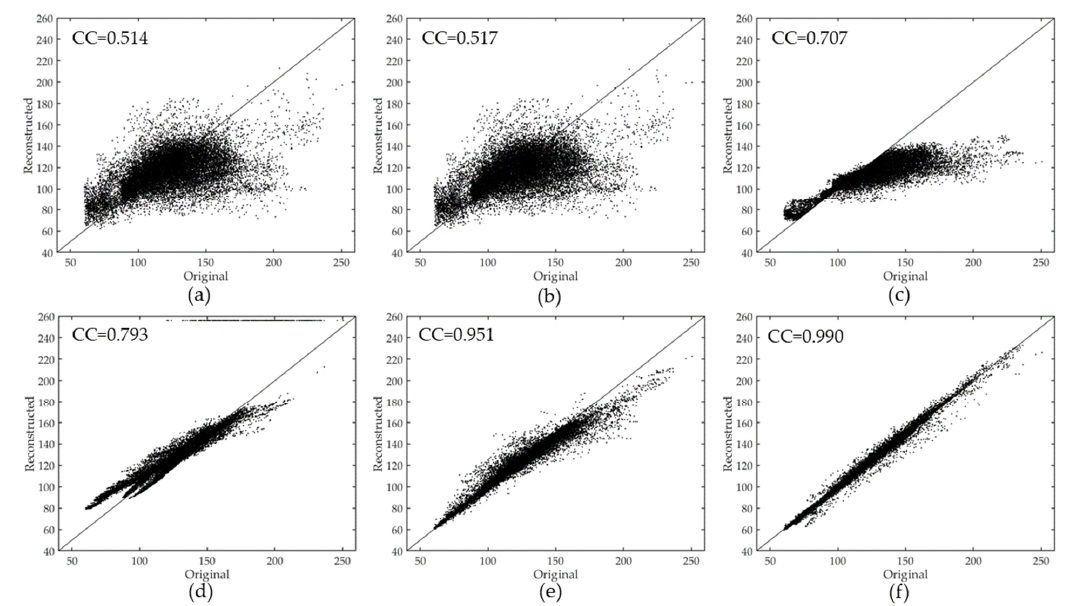
Figure 9. The scatterplots of the original and the reconstructed values in the first simulated experiment: ( a ) the FaLRTC method; ( b ) the HaLRTC method; ( c ) the TRPCA method; ( d ) the TVLRSDC method; ( e ) the TOS method; ( f ) the proposed TSSTO method. In the second simulated experiment, the proposed TSSTO method is tested on eight SPOT-5 images with four bands (bands 1, 2, 3, and 4) which were acquired in 2015, in Beijing. The size of the experimental images is 512 × 512 pixels. The original images of false-color composition (red: band 3; green: band 2; blue: band 1) are shown in Figure 10a. The results of the different methods are shown